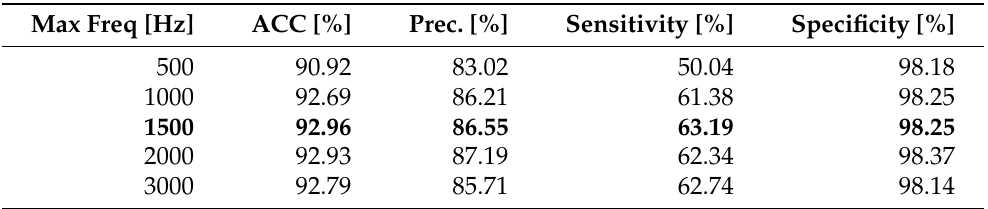
Table 2. Results of the linking model on the validation set, depending on the maximum frequency of the spectrogram max freq . The data come from the best eras. They were obtained by the fivefold cross-validation method.